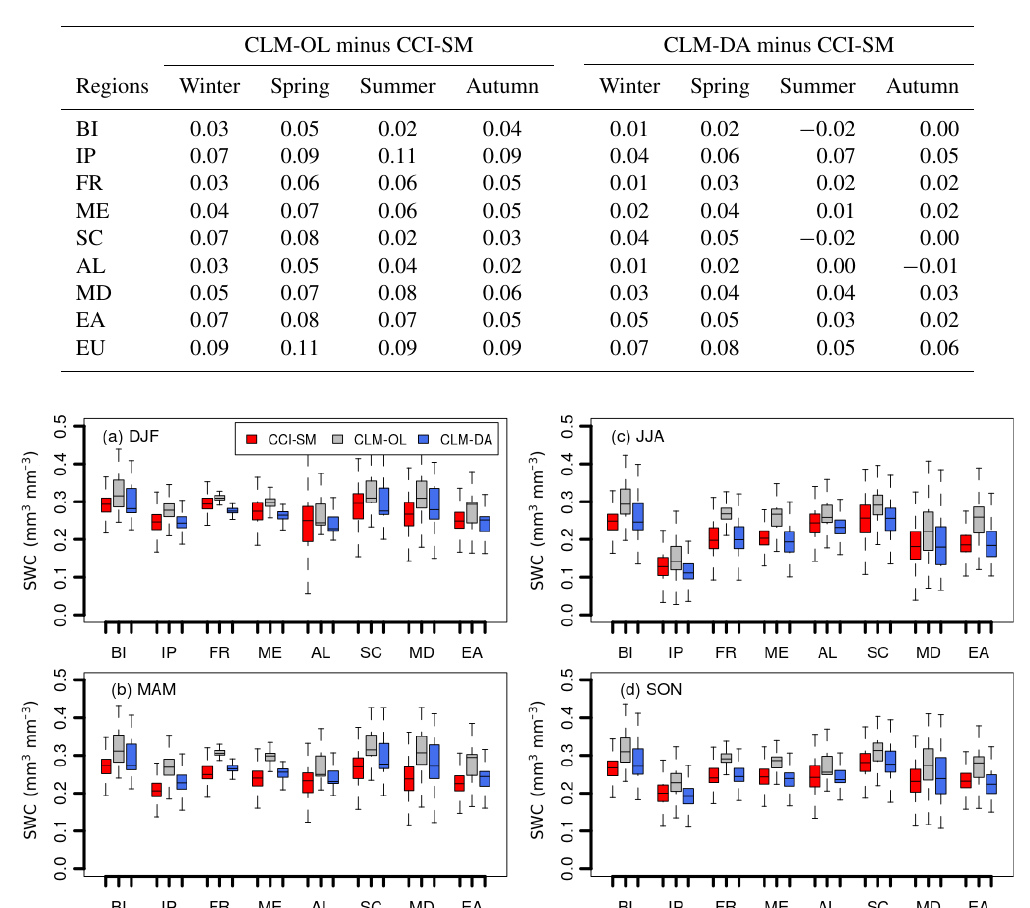
Figure 4. Box plots showing the spread of seasonally averaged soil water content (mm 3 mm − 3 ) over the 2000–2006 time period and in the PRUDENCE regions for (a) DJF, (b) MAM, (c) JJA and (d) SON seasons. The box plots illustrate the spatial distribution of SWC with quartiles, median and extreme values marked by solid